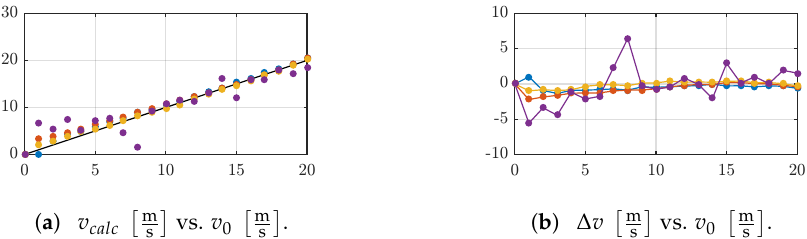
Figure 8. ( a ) The calculated velocity v calc is compared to the measured one v 0 : D03 (magenta), D4 (blue), D5 (red), (D6) yellow. The black line corresponds to the original v 0 . ( b ) According to ( a ), the error ∆ v is calculated by ∆ v = v 0 − v calc .